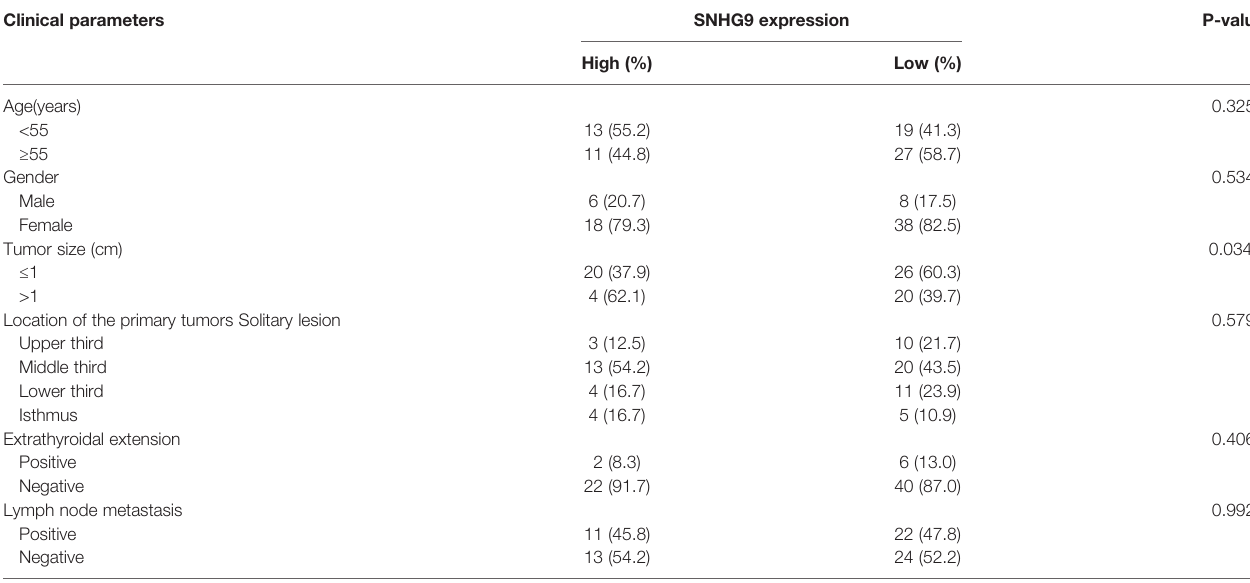
TABLE 1 | The correlation of SNHG9 with the clinicopathological characteristics of PTC patients in the FUSCC. Clinical